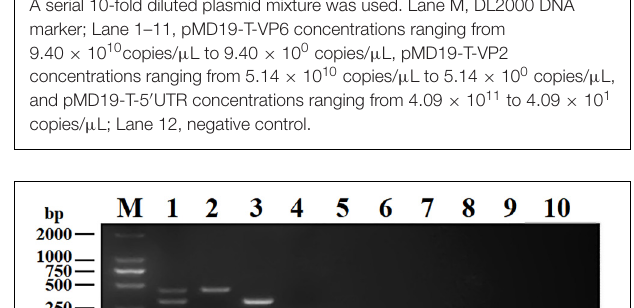
FIGURE 5 | The DPO-nanoPCR assay for detection of BRV, BPV and BVDV. Lane M: DL2000 DNA marker; Lane 1, pMD19-T-VP6; Lane 2, pMD19-T-VP2; Lane 3, pMD19-T-5 (cid:48) UTR; Lane 4, pMD19-T-VP6 and pMD19-T-VP2; Lane 5, pMD19-T-VP6 and pMD19-T-5 (cid:48) UTR; Lane 6, pMD19-T-VP2 and pMD19-T-5 (cid:48) UTR; Lane 7, pMD19-T-VP6, pMD19-T-VP2 and pMD19-T-5 (cid:48) UTR; Lane 8, negative control.